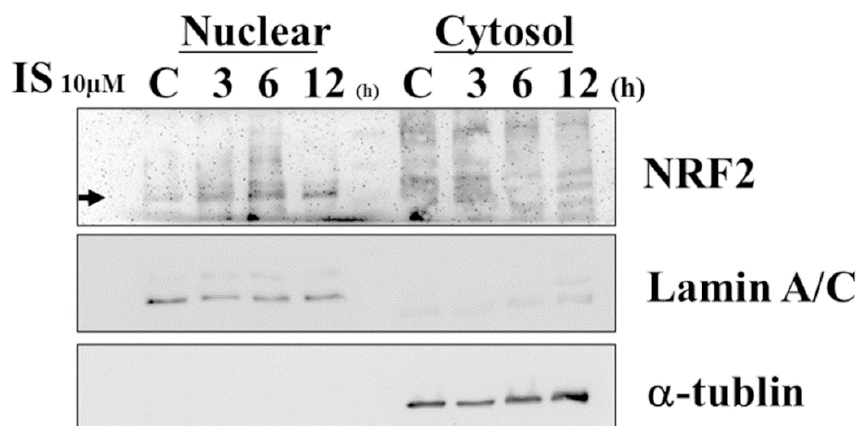
Figure 8. Representative immunoblot analysis of NRF2 in nucleus and cytosol. NRF2 was detected and normalized to lamin A/C in the nucleus and α -tubulin in cytosol. After astrocytes were treated with 10 µ M IS for different durations (3, 6, and 12 h), NRF2 was examined in nuclear and cytosolic fractions. NRF2 protein expression was decreased in cytosol and increased in the nucleus.